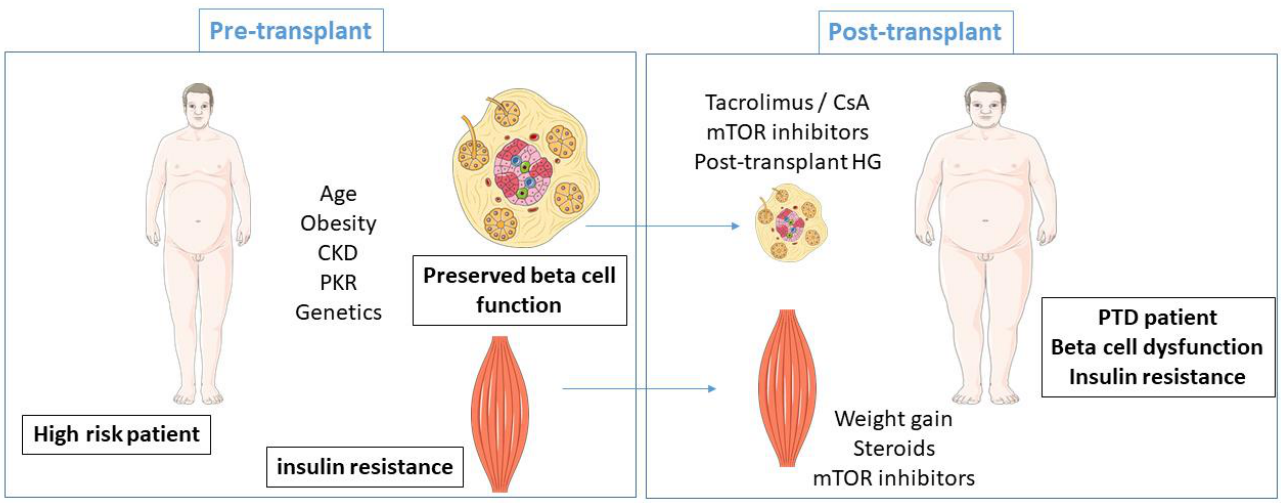
Figure 1. Summarized pathogenesis of post-transplant diabetes. (CKD, chronic kidney disease; HG,